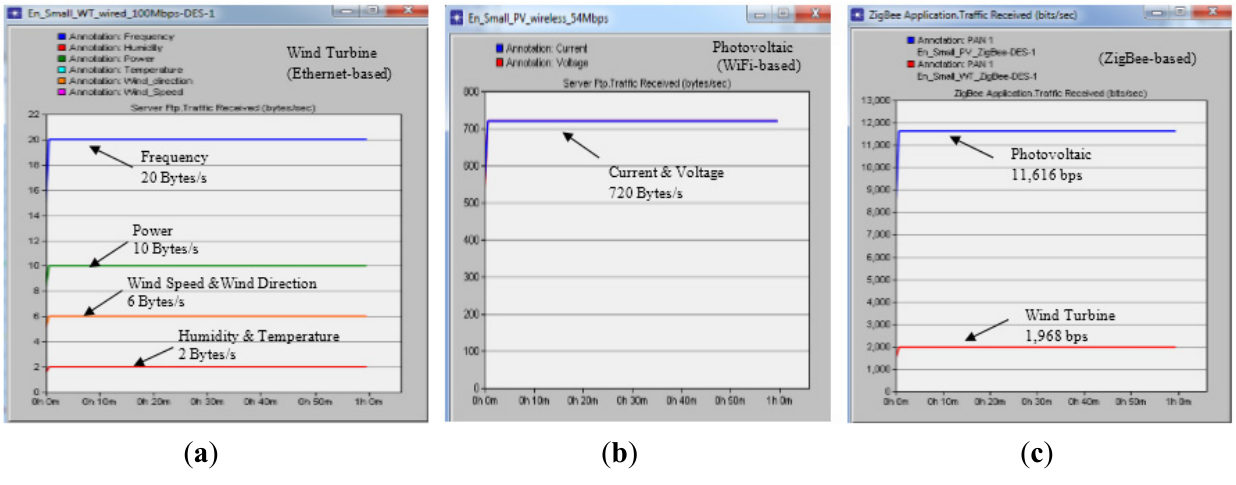
Figure 8. Traffic received at the server. ( a ) Ethernet-based architecture for WT;